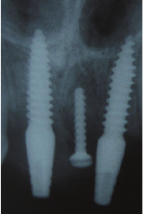
Figure 4: postoperative radiograph showing implant and screw.